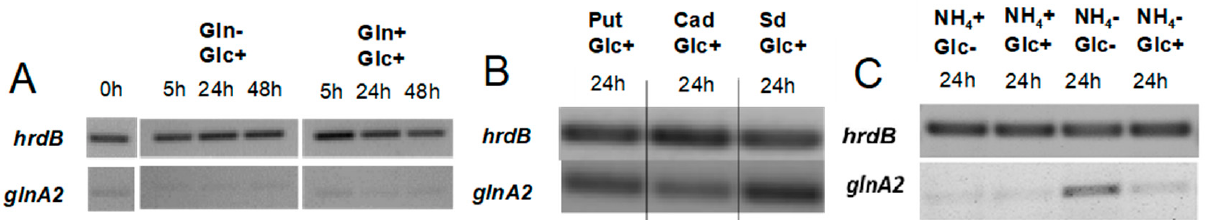
Figure 5. Transcription analysis of glnA2 in S. coelicolor M145 under different N-conditions. RT-PCR of glnA2 and hrdB in S. coelicolor M145 cultivated in minimal Evans medium with: ( A ) low 5 mM (Gln − ) or high 50 mM (Gln+) glutamine concentration; ( B ) high 25 mM polyamine concentration (Put: putrescine, Cad: cadaverine, Sd: spermidine); ( C ) low 5 mM (NH 4 − ) or high 50 mM (NH 4 + ) ammonium/low 2.5 g/L (Glc − ) or high 25 g/L (Glc+) glucose concentration. Total RNA was isolated